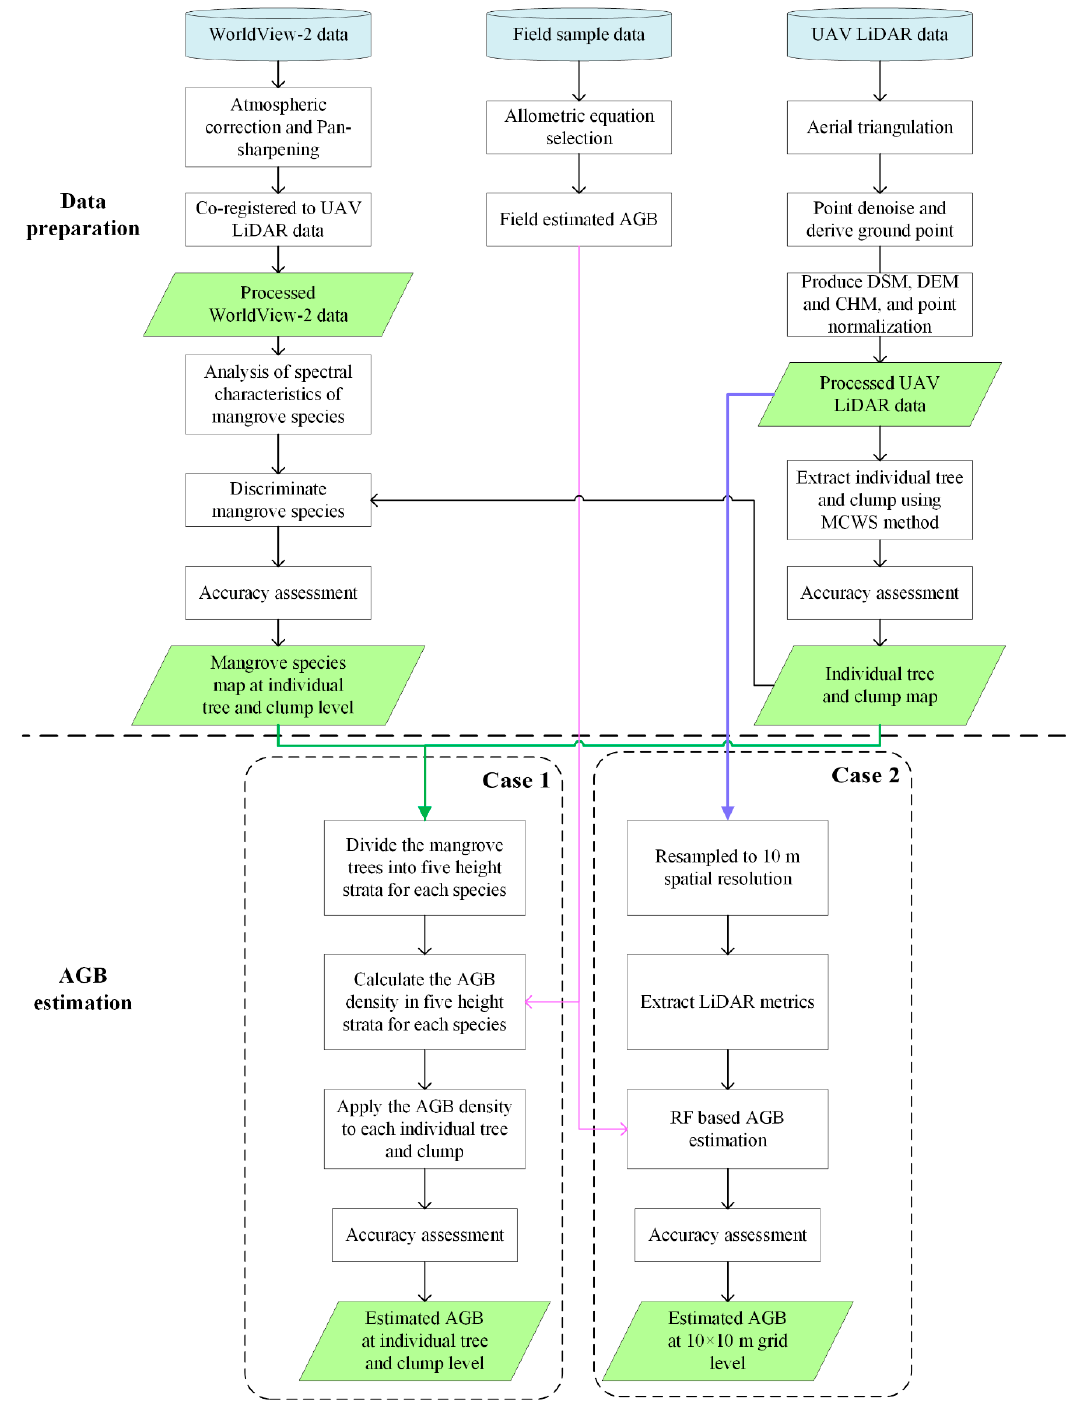
Figure 2. Workflow of estimating mangrove aboveground biomass (AGB). Case 1 denotes the mangrove AGB estimation at individual tree level, namely the individual tree-based inference method. Case 2 denotes the common model-based AGB estimation at grid level, namely the grid-based random forest model method, which is used as a benchmark in this study.